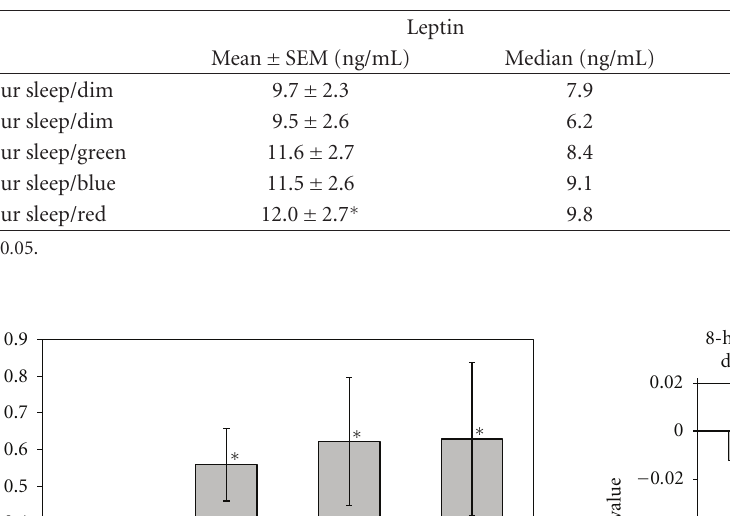
Table 1: Mean ± SEM and median concentrations of leptin and ghrelin. Exposure to red light significantly ( P < 0 . 05) increased leptin concentrations compared to the remaining in dim-light condition after both 8-hour sleep and 5-hour sleep schedules.